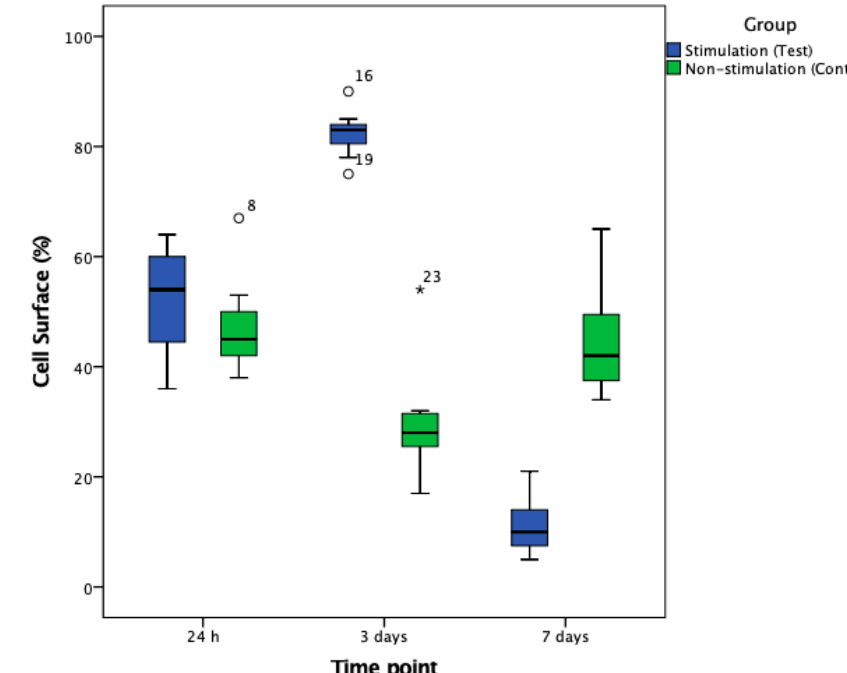
Figure 5. Boxplots for illustration of cellular surface coverage in stimulated and non-stimulated cell samples after 24 h, 3 and 7 days of continuous electrical stimulation. At days 3 and 7, significant differences were seen (each p < 0.001).